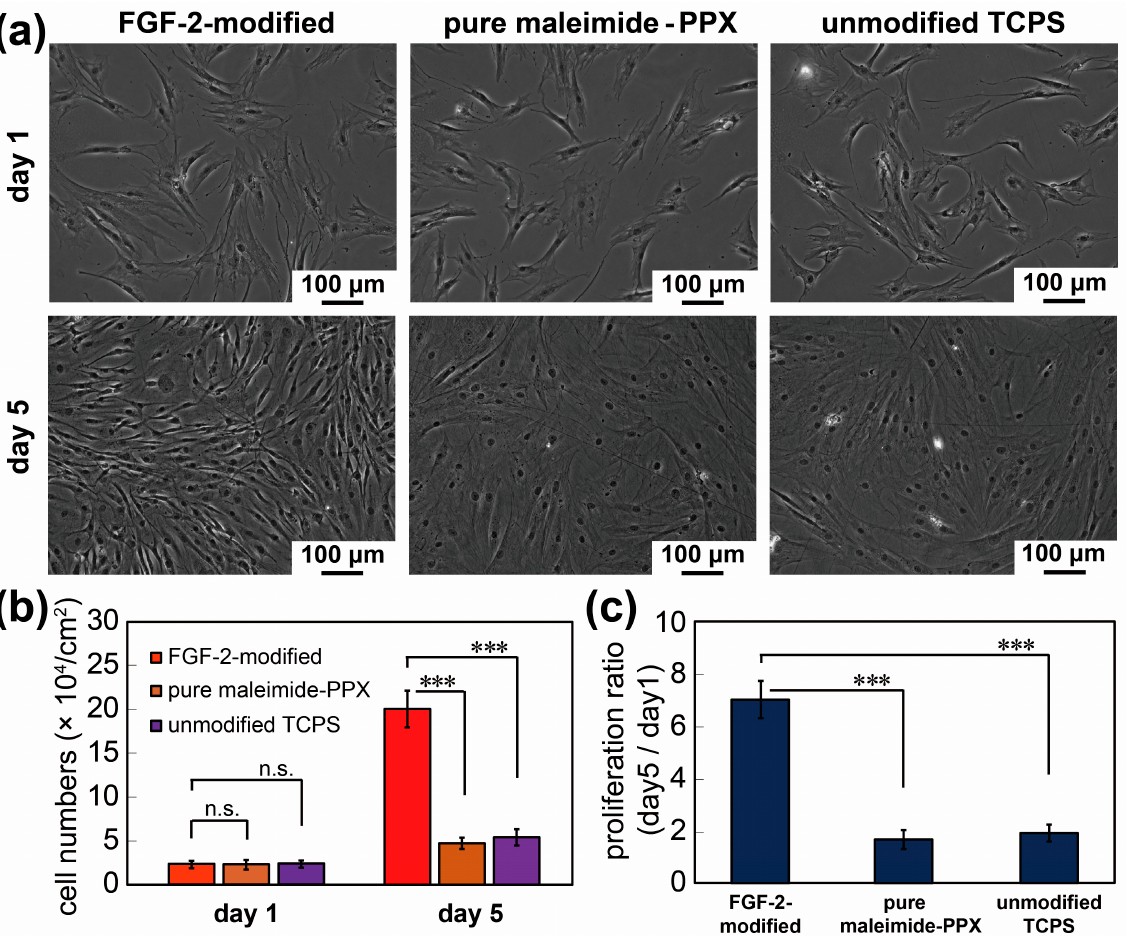
Figure 6. The proliferation activities of hADSCs were examined on the studied surfaces. ( a ) Phase-contrast micrographs of cell growth patterns recorded on day 1 and day 5. ( b ) Estimated cell numbers on day 1 and day 5 were compared for these surfaces. ( c ) The proliferation ratio that statistically normalized the cell numbers on day 5 to day 1 was compared for these studied surfaces. The data bars represent the mean value (n = 3) and the standard deviation (±SD) based on three independent experiments. The significance levels n.s. and *** stand for nonsignificant difference and *** p < 0.001, respectively, and are shown by the results of the unpaired t -test.